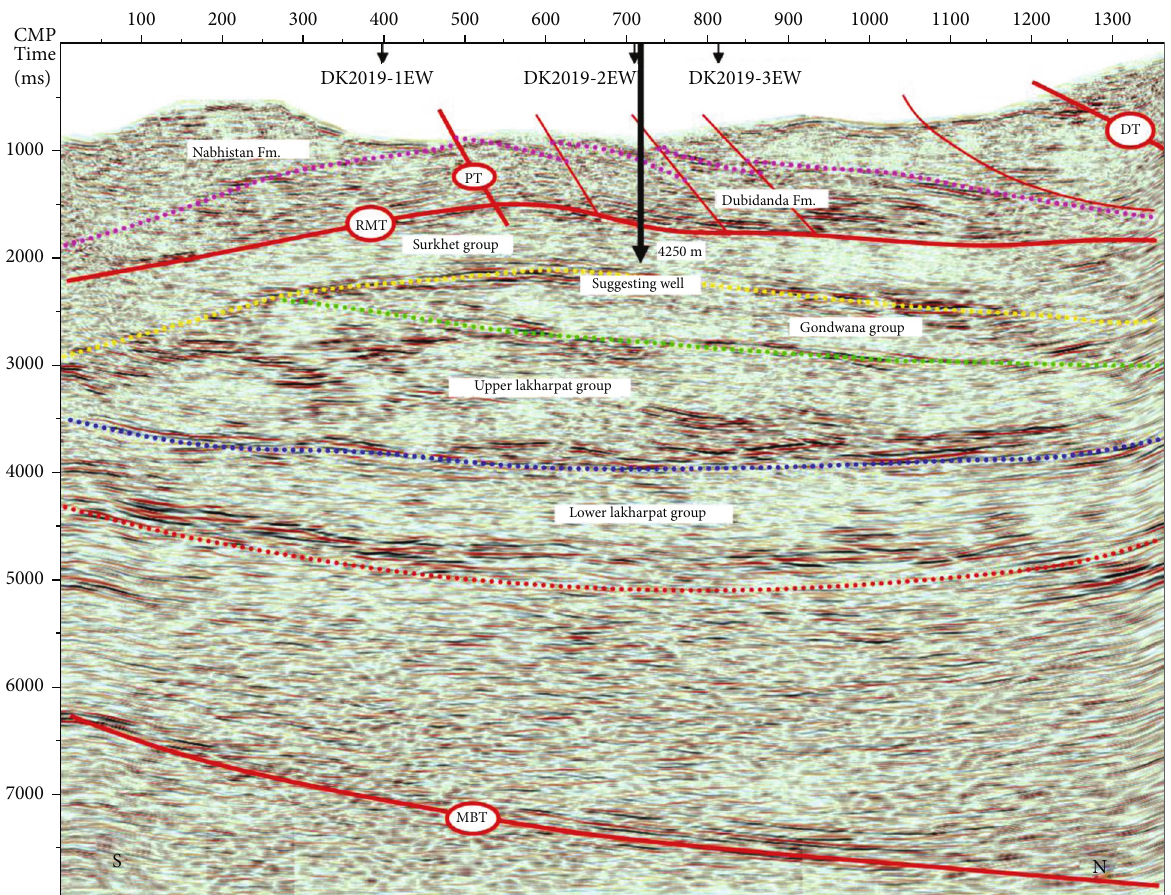
Figure 18: The geological interpretation scheme of PSTM section